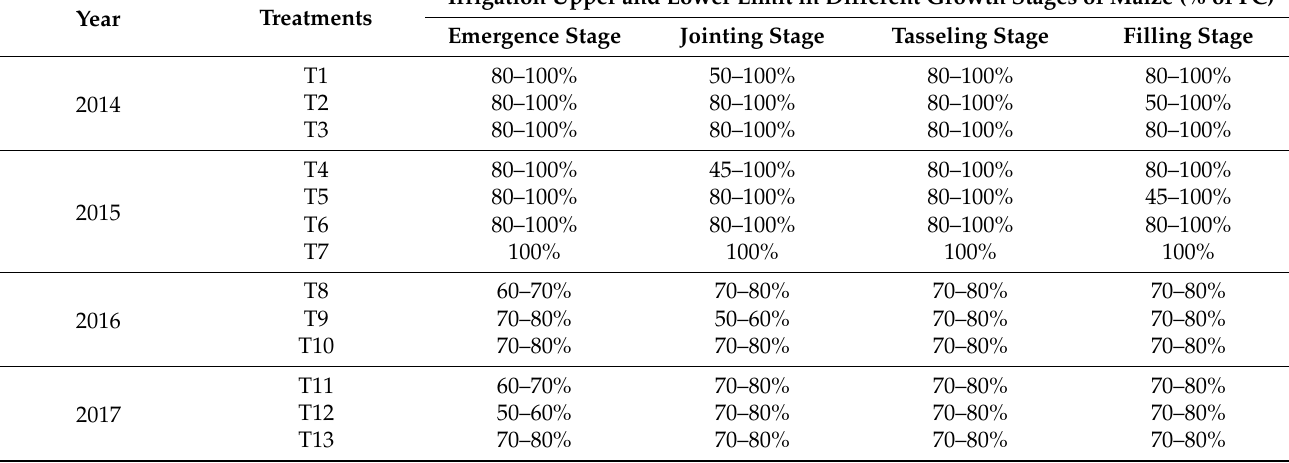
Table 1. Irrigation treatments from 2014 to 2017.